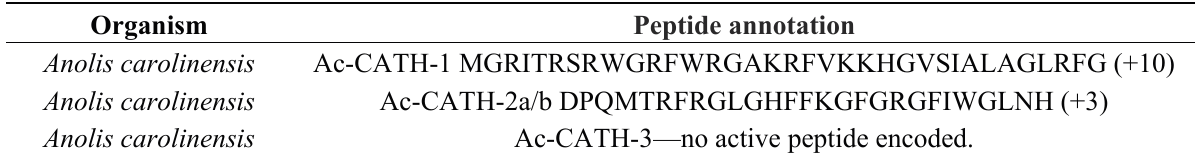
Table 4. Predicted active cathelicidin peptides in the anole lizard [91,92].